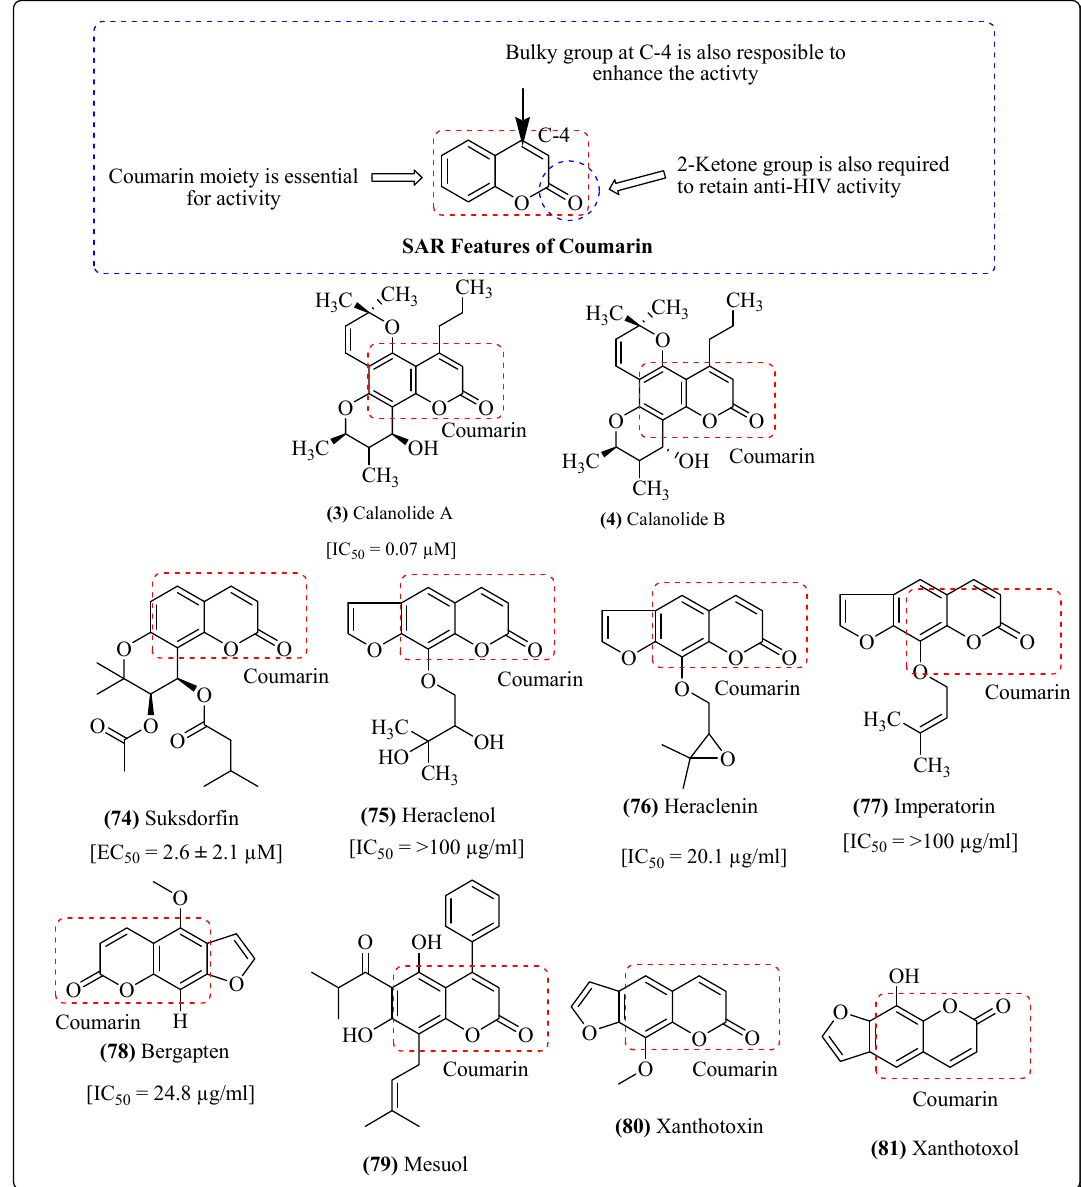
Figure 15. Coumarins with significant Anti-HIV potential.